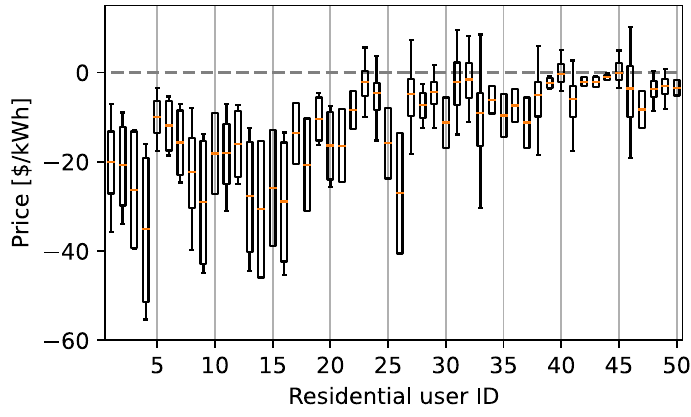
Figure 8. Aggregator profit by each user in Case 4 considering Price 1.